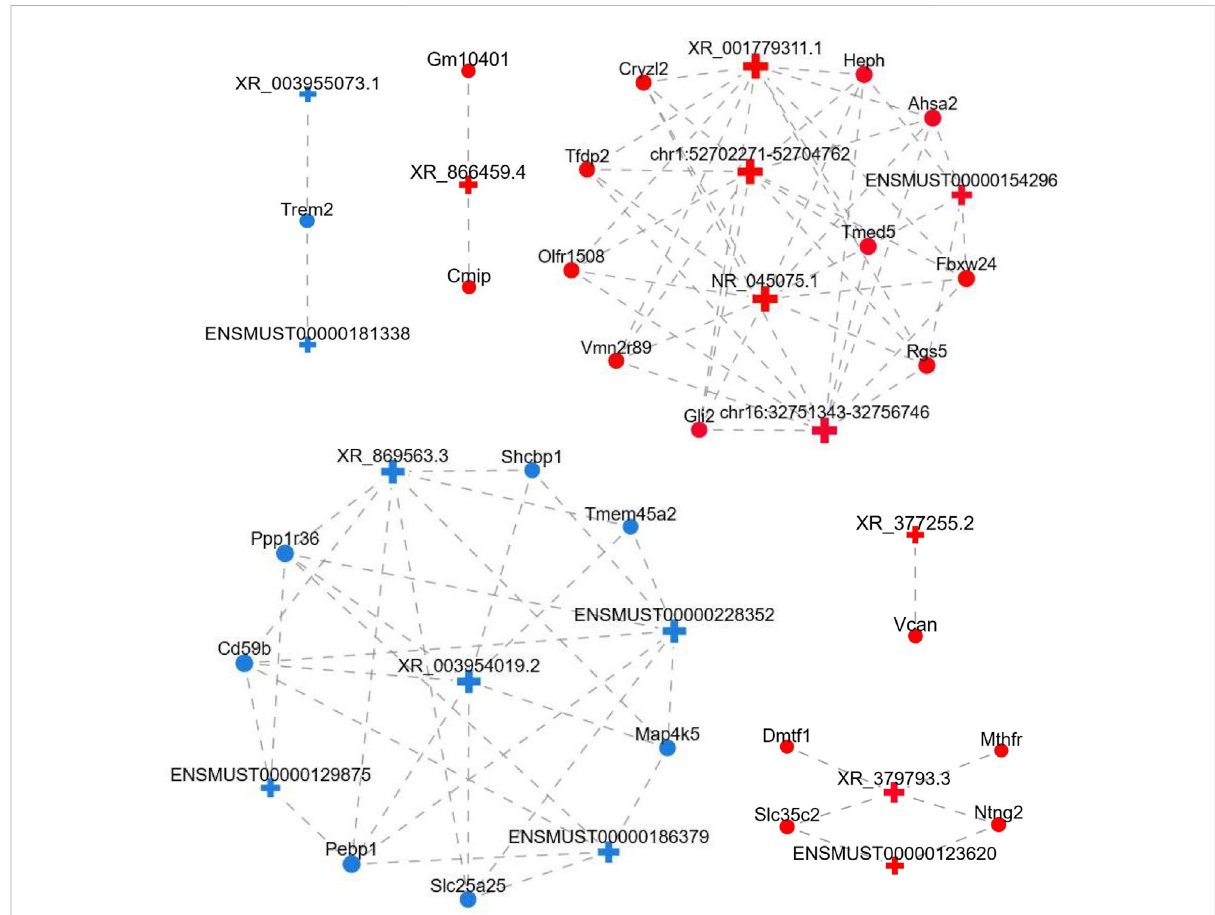
FIGURE 6 LncRNA-mRNA coexpression network. LncRNAs and mRNAs with Corr > 0.95 and p value < 0.05 were selected to construct the network. The network shows the interactions among the lncRNAs and their potential regulated coding genes. Red, upregulated; blue, downregulated; cross, lncRNA; circle, mRNA; gray dotted line, correlation